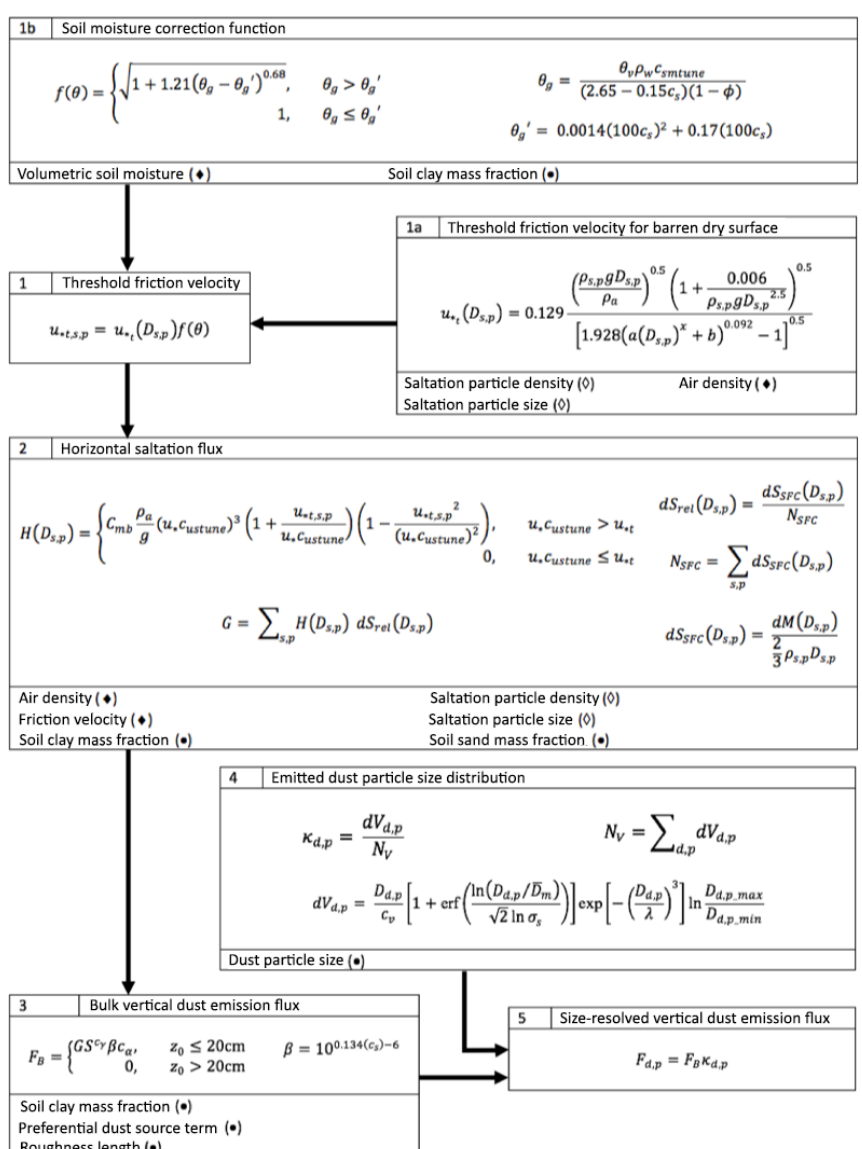
Figure 1. Schematic diagram of AFWA dust emission scheme and required inputs. The black diamond marker indicates that the parameter varies spatially and temporally. The black circle marker indicates that the parameter varies spatially, and the hollow diamond marker indicates the term is related to a particle size bin. See comprehensive variable list in Appendix B for variable